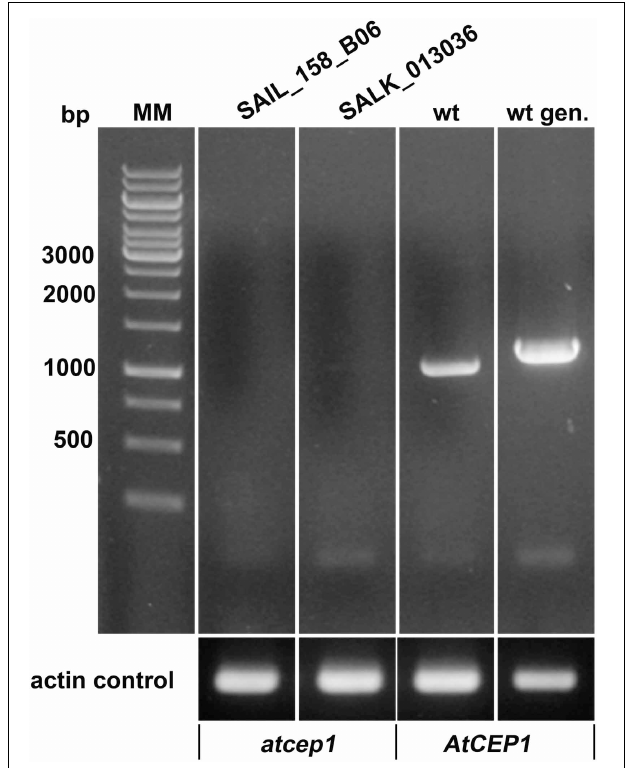
FIGURE 1 | Both AtCEP1 mutants SAIL_158_B06 and SALK_013036, harboring the T-DNA insertion in the 3. exon represents loss of function mutants. No corresponding transcript could be amplified by RT-PCR using primers that comprise the complete coding region from 7 days old seedlings, whereas the parent Col-0 wild type expressed the gene. wt, RT-PCR on wild type RNA; wt gen, PCR on wild type genomic